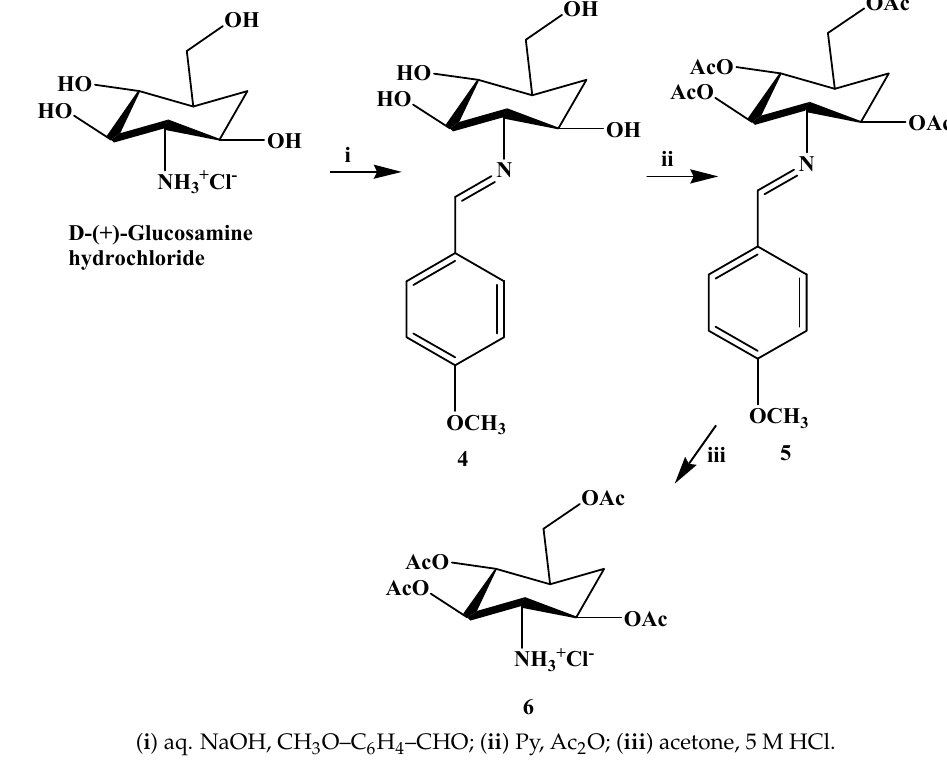
Scheme 1. Chemical synthesis of compound 6 .